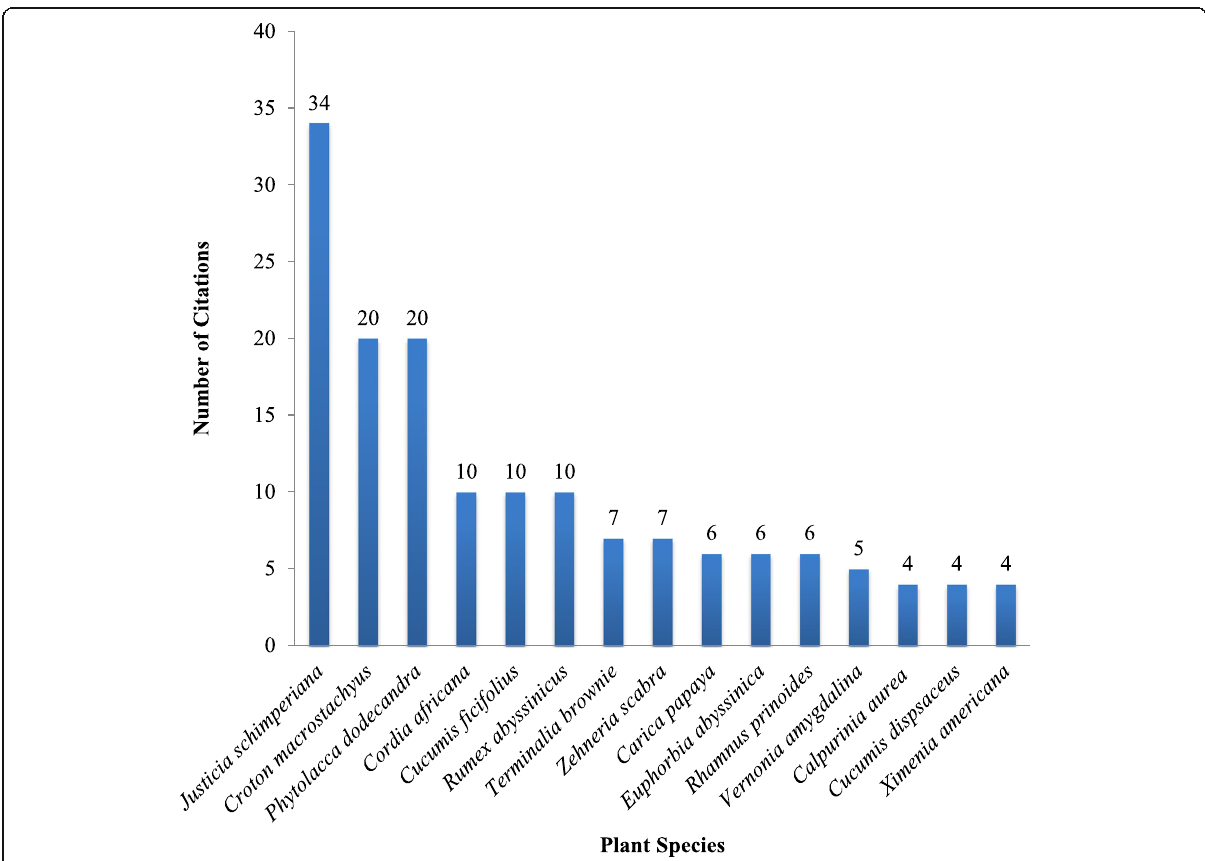
Fig. 2 Frequently used plant species for the treatment of hepatic disorders in